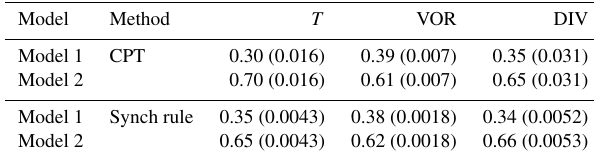
Table 3. Weights for the supermodel trained by CPT and the synch rule. Between brackets, the standard deviation over the year (CPT) or the standard deviation over the last 10 weeks of training (synch rule) is